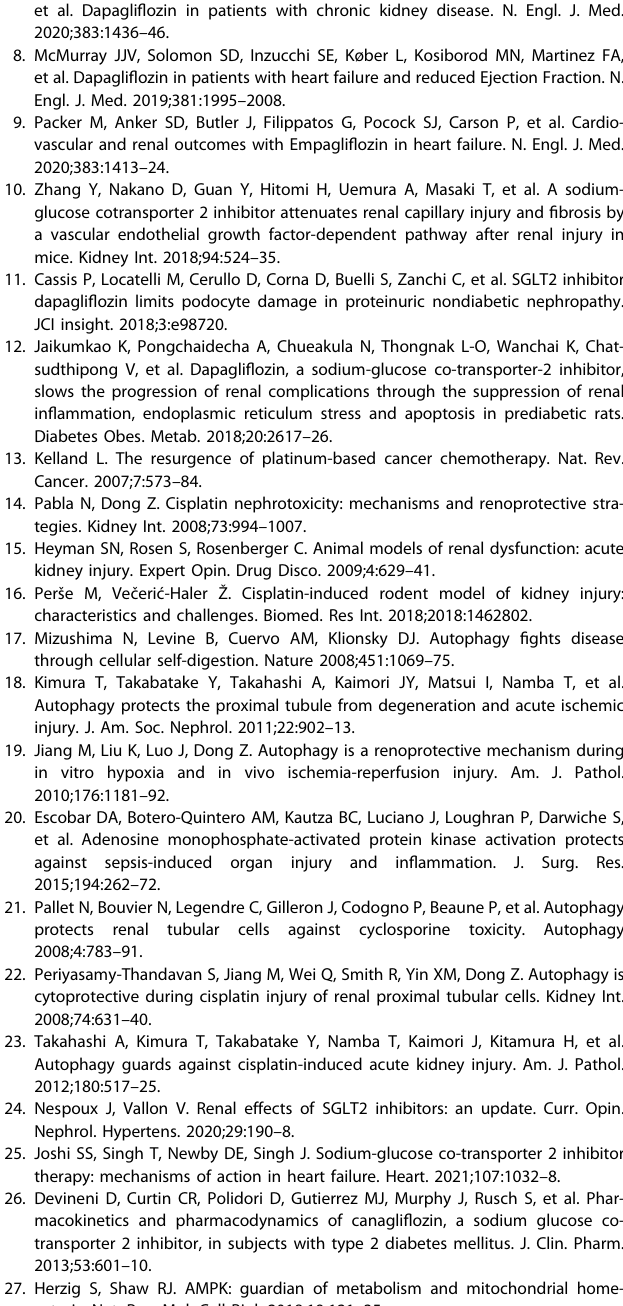
Fig. 6 Inhibition of AMPK activation eliminates the protective effect of canagli fl ozin against cisplatin-induced AKI in mice. C57BL/6 mice were administered with canagli fl ozin (CANA) (10 mg/kg) or vehicle orally and intraperitoneally injected with compound C (Comp. C) (5 mg/kg) or saline for fi ve consecutive days, and intraperitoneal injection of cisplatin (20 mg/kg) or saline was done on the 5th day of the treatment. Mice were euthanized at 72 h after cisplatin injection to collect blood samples for measurements of blood urea nitrogen and serum creatinine and kidney tissues for histology. A Representative images of kidney H – E staining (scale bar = 100 μ m). B Blood urea nitrogen. C Serum creatinine. D Tubular injury score. Data are expressed as mean ± SD ( N = 5 – 6). Differences between groups were evaluated using one-way ANOVA followed by Bonferroni ’ s multiple comparison test. *** P < 0.001. NS, not signi fi cant. E Representative images of TUNEL staining (scale bar = 60 μ m). F Quanti fi cation of TUNEL-positive cells in kidney tissues. Data are expressed as mean ± SD ( N = 5 – 6). Differences